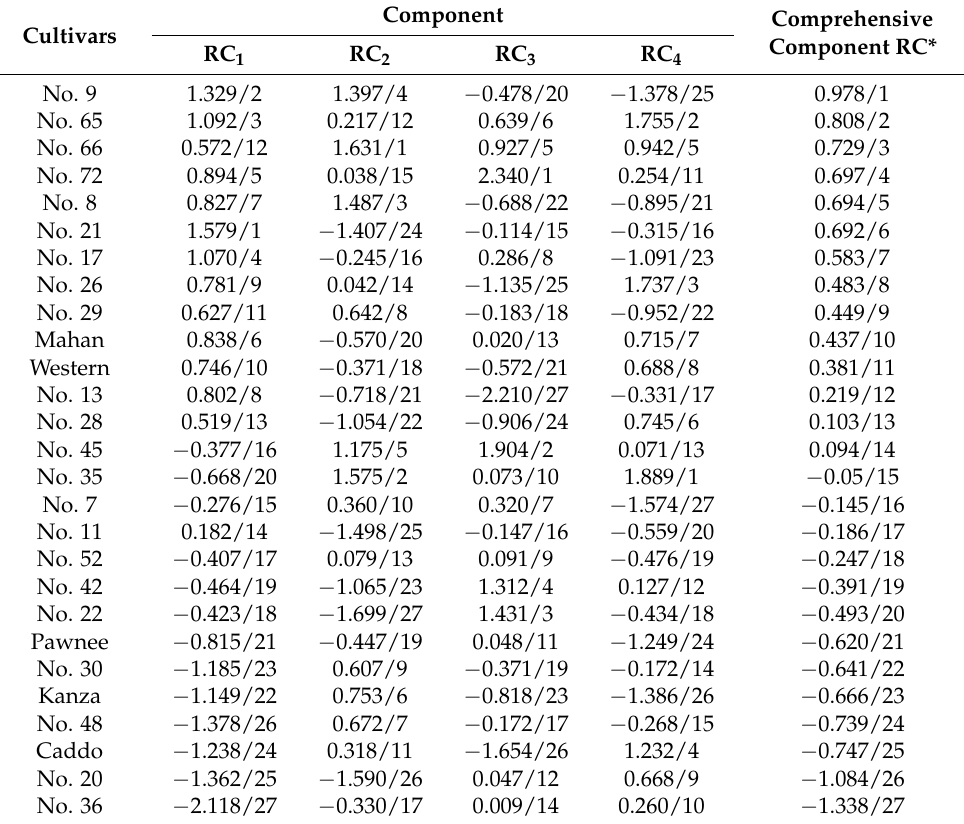
Table 6. Principal component value of the mineral nutrients in pecan kernels. Cultivars